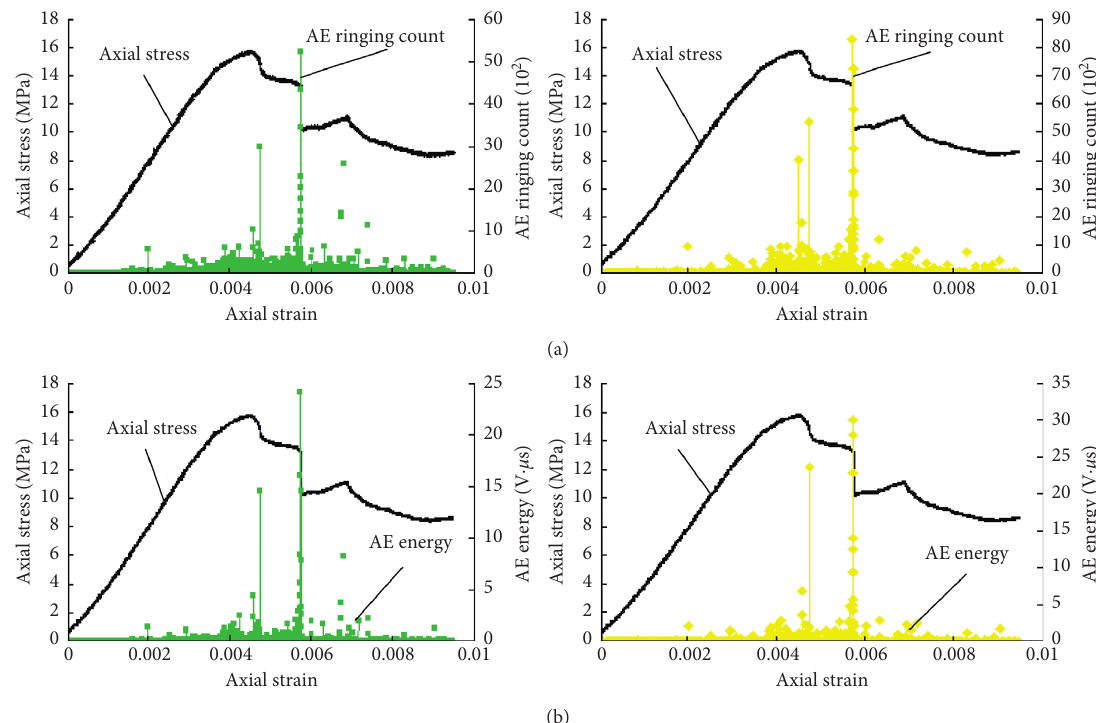
Figure 5: Acoustic emission parameter curves of coal sample. (a) AE ringing count and (b) AE